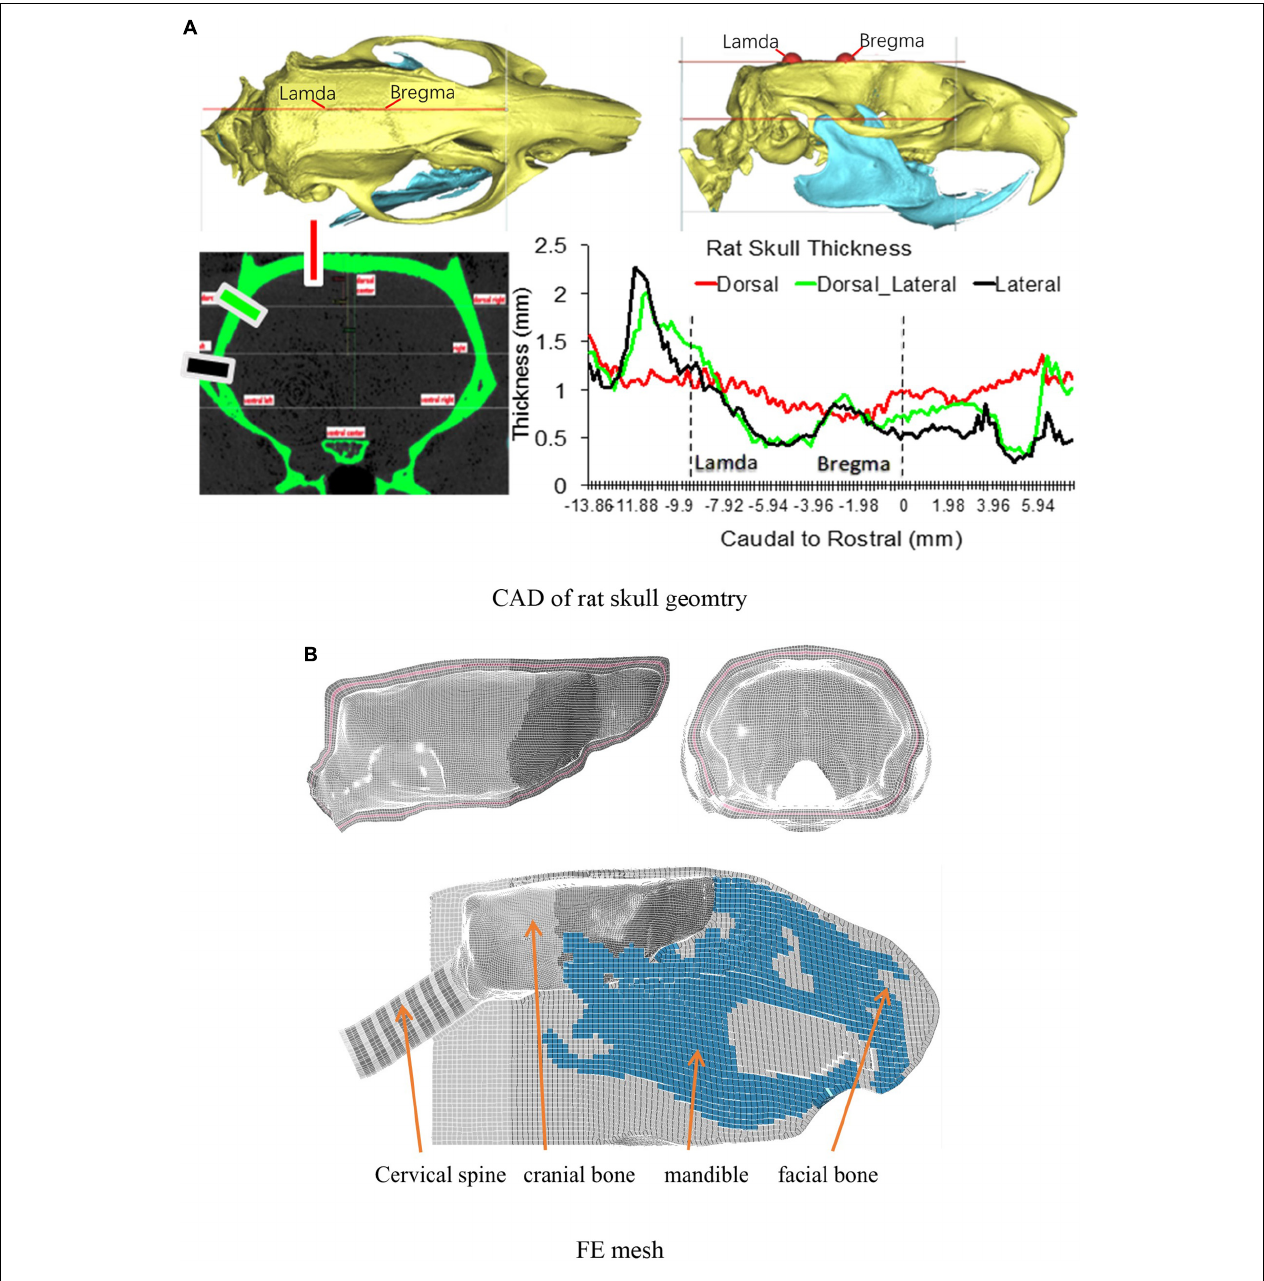
using Mimics 11.11 (Materialise, Leuven, Belgium) based